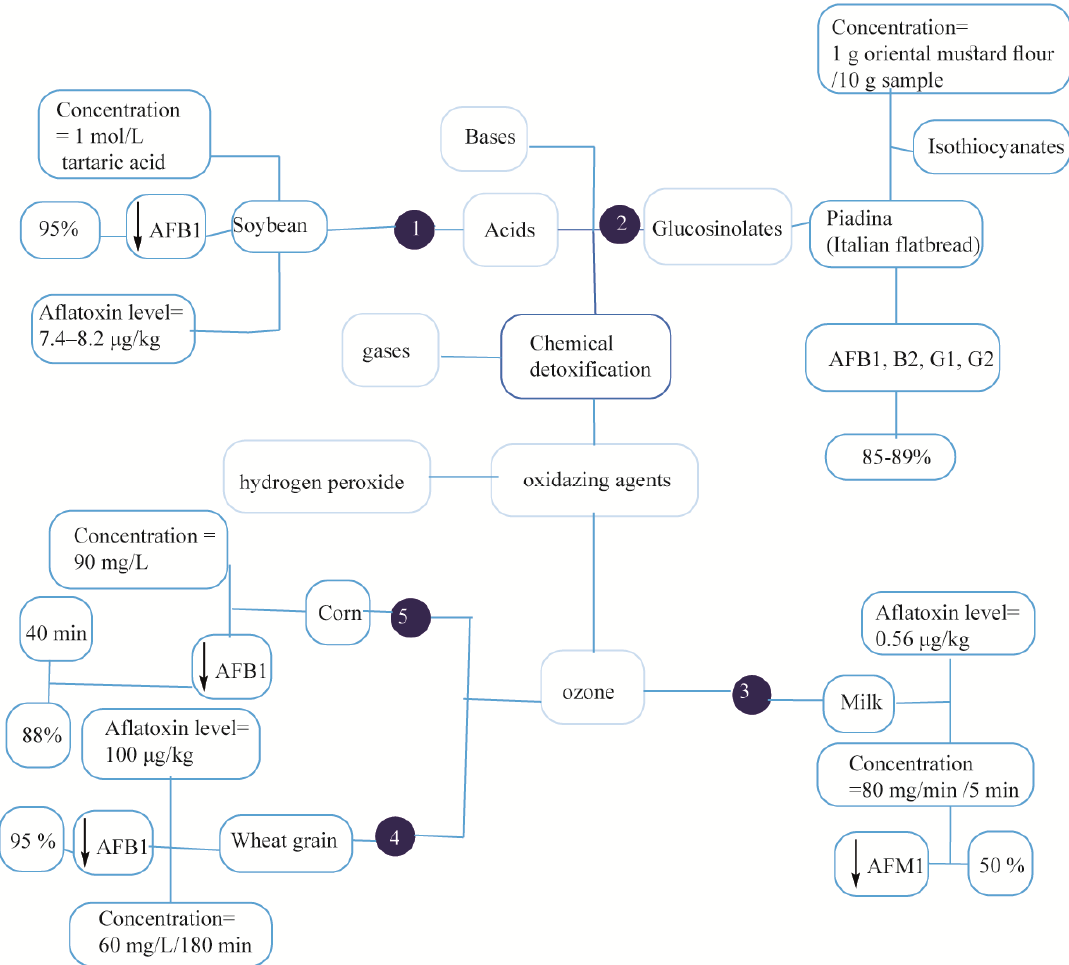
Figure 3. Overview of chemical detoxification methods. (1, [171]), (2, [172]), (3, [173]), (4, [174]), (5, [175]).